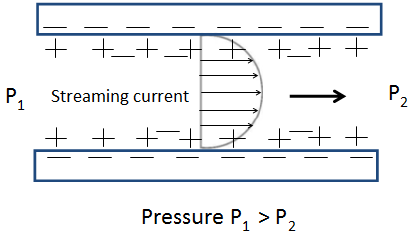
nt of streaming